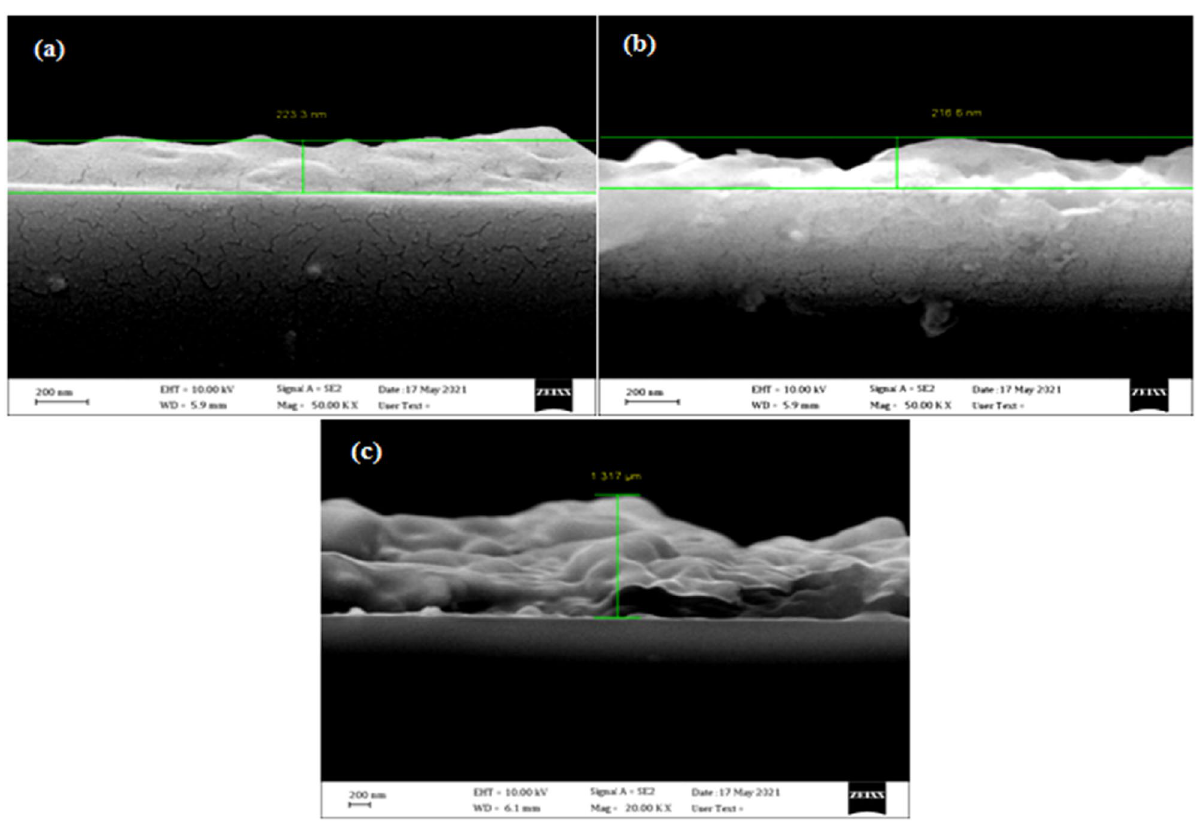
Figure 5. FESEM images of cross-section images of B 4 C NPs synthesized at different laser pulses prepared at ( a ) 500, ( b ) 1000, and ( c ) 1500